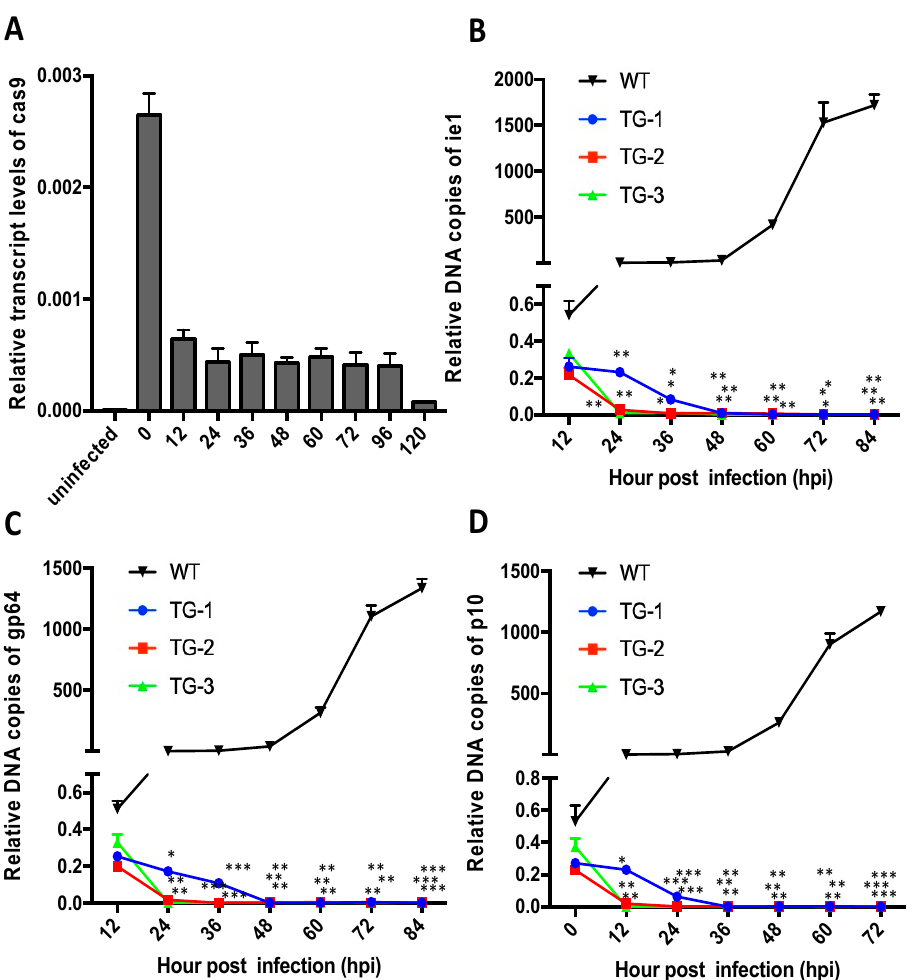
Figure 5. Antiviral efficiency of the BmNPV-inducible CRISPR/Cas9 system. ( A ) qRT-PCR analysis of Cas9 mRNA in TG-1 silkworms infected with 10 6 OBs/larva. ( B – D ) Relative numbers of copies of BmNPV genes ( B ) ie-1 , ( C ) gp64 , and ( D ) p10 determined by qPCR at different time points after viral inoculation with 10 6 OBs/larva. Data represent the means ± SEM. * p < 0.05; ** p < 0.01; *** p < 0.001 by two-way ANOVA.